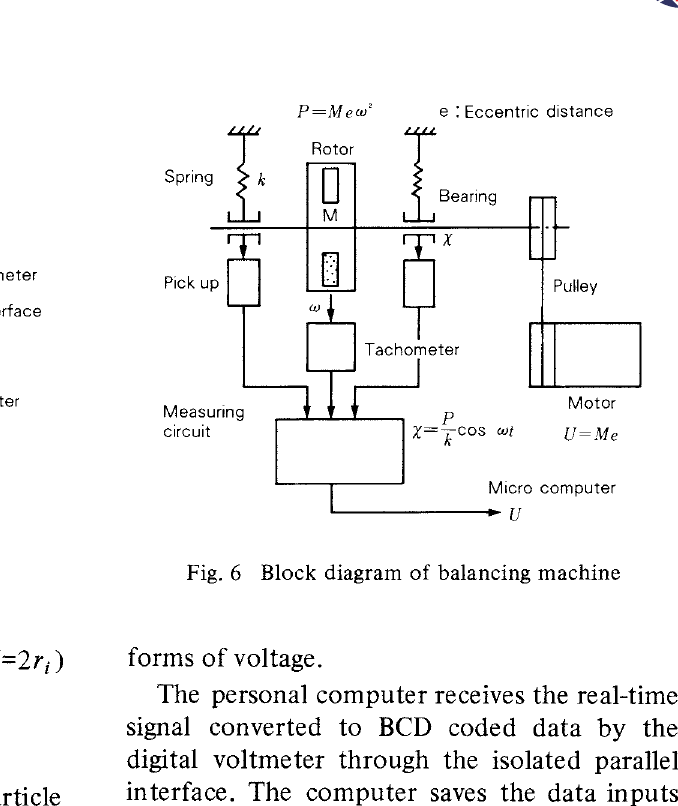
Fig. 4 Measuring system